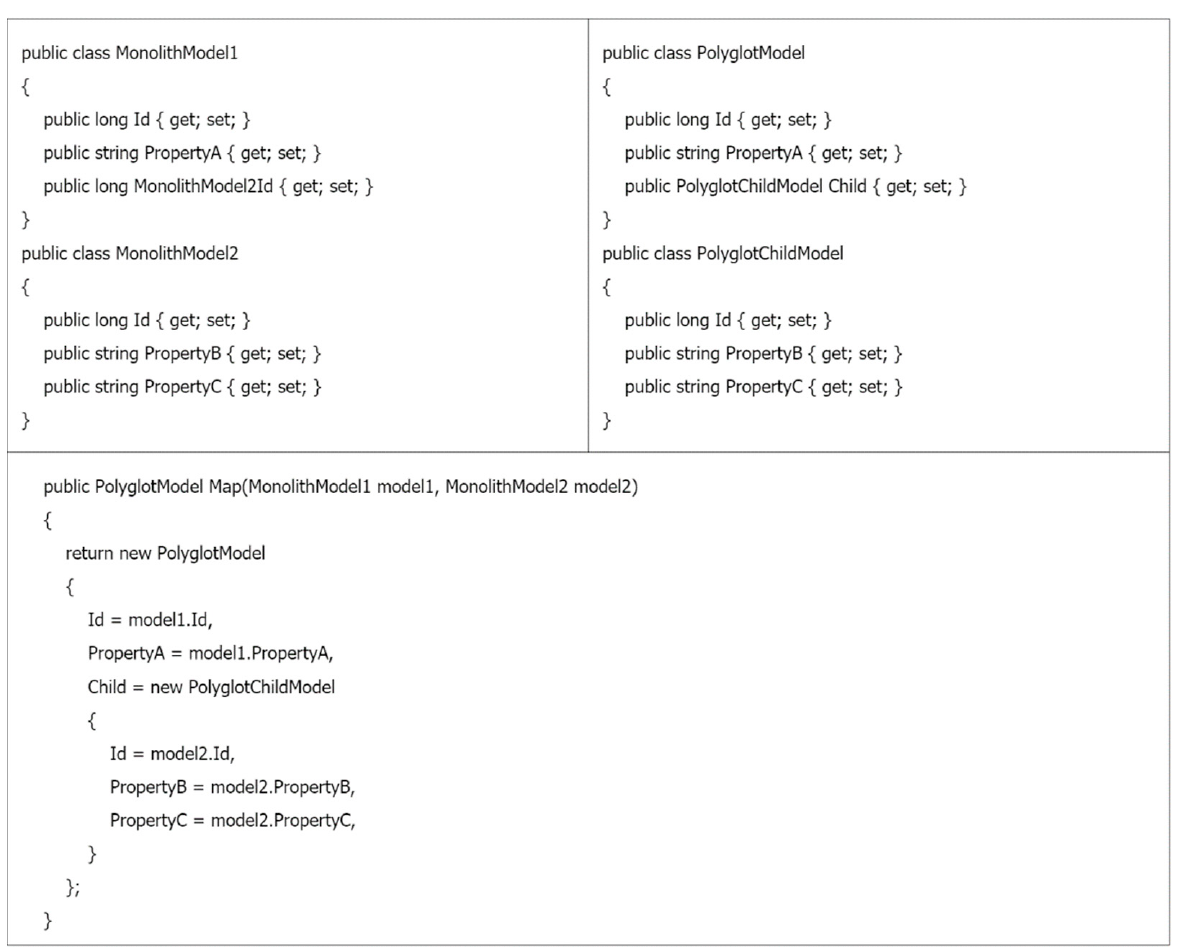
Figure 7. An example of simplified data model mapping.